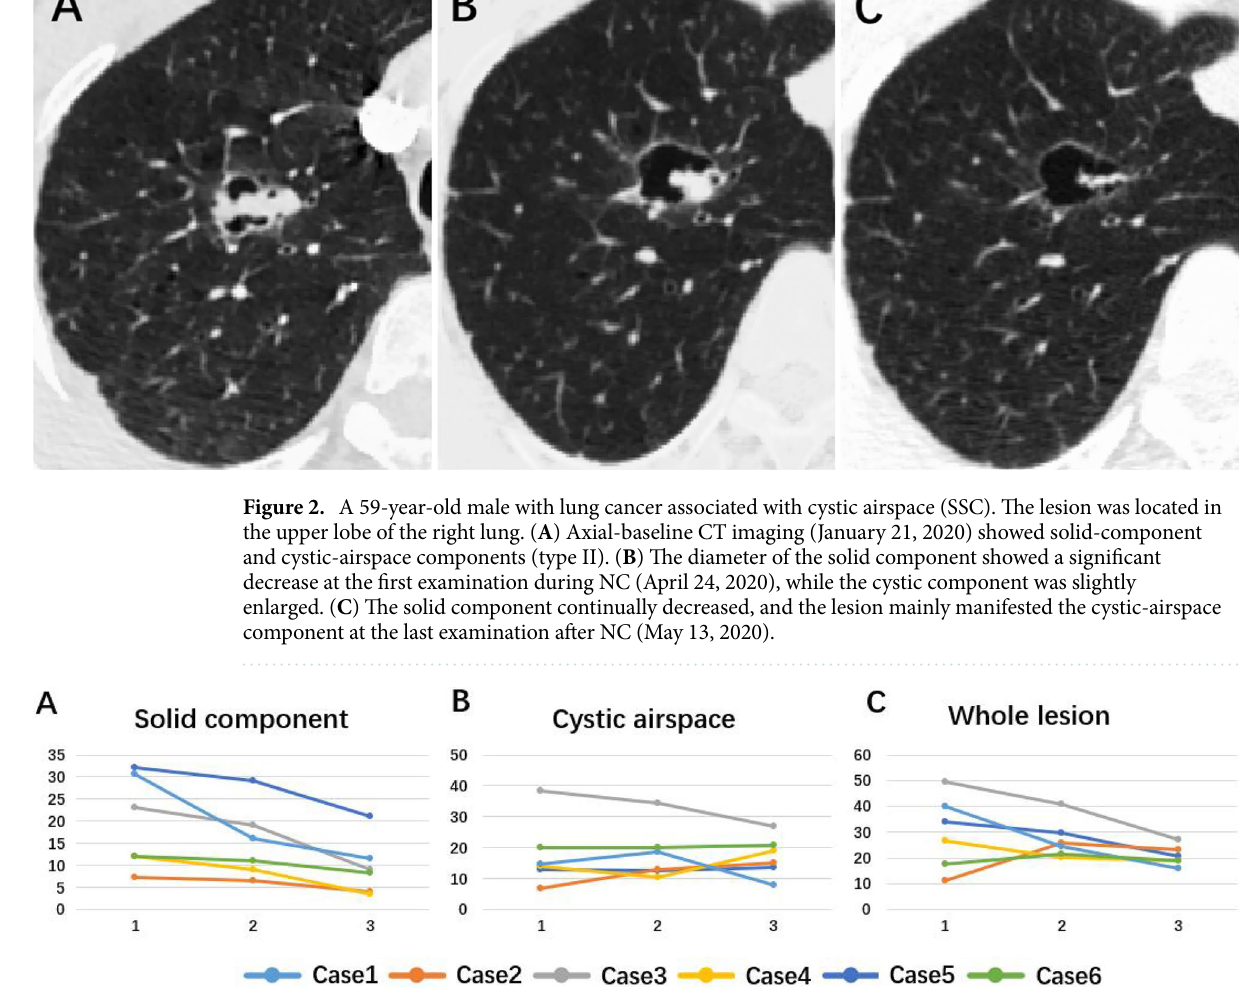
Figure 3. Changes in maximum diameter of different components after NC in six cases. The first abscissa represents the initial CT examination (Baseline) before NC, the second abscissa represents the first CT examination (First Time) during NC, and the last abscissa represents the last CT examination (Last Time) after NC. ( A ) Solid component; ( B ) cystic airspace; ( C ) whole treatment. For Δ1, the whole-tumor area of all six lesions decreased (from − 5.3 to − 62.1%); for Δ2, the whole- tumor area of five lesions was reduced (from − 4.5 to − 81.7%; Supplementary Table 4, Fig. 4). Volumes of different components. Similarly, solid-component volume decreased significantly in all six lesions during follow-up (Table 2). In terms of cystic-airspace volume, three lesions decreased and three increased at the first CT examination (Δ1 ranged from − 6.5 to − 76.9% and from + 70.0 to + 591.8%, respectively). However, at the last CT examination after treatment, only one lesion decreased in cystic volume (Δ2 = − 90.7%). In terms of whole-lesion volume, four lesions decreased (Δ1 ranged from − 13.7 to − 73.4%, Δ2 from − 17.1 to − 95.2%; Supplementary Table 5, Fig. 5). Comparisons of different measurement parameters (diameter, area, volume) with serial CT. The magnitude of variation was larger in volume and area than in diameter (Table 2). For diameter, area, and volume, Δ1 of measured changes in the solid component ranged from − 8.3 to − 46.9, − 19.4 to − 70.8, and − 19.1 to − 94.7, respectively; while Δ2 ranged from − 30.8 to − 69.2, − 50.8 to − 92.1, and − 32.7 to − 99.8, respectively. Changes in cystic-airspace and whole-tumor parameters showed similar results.